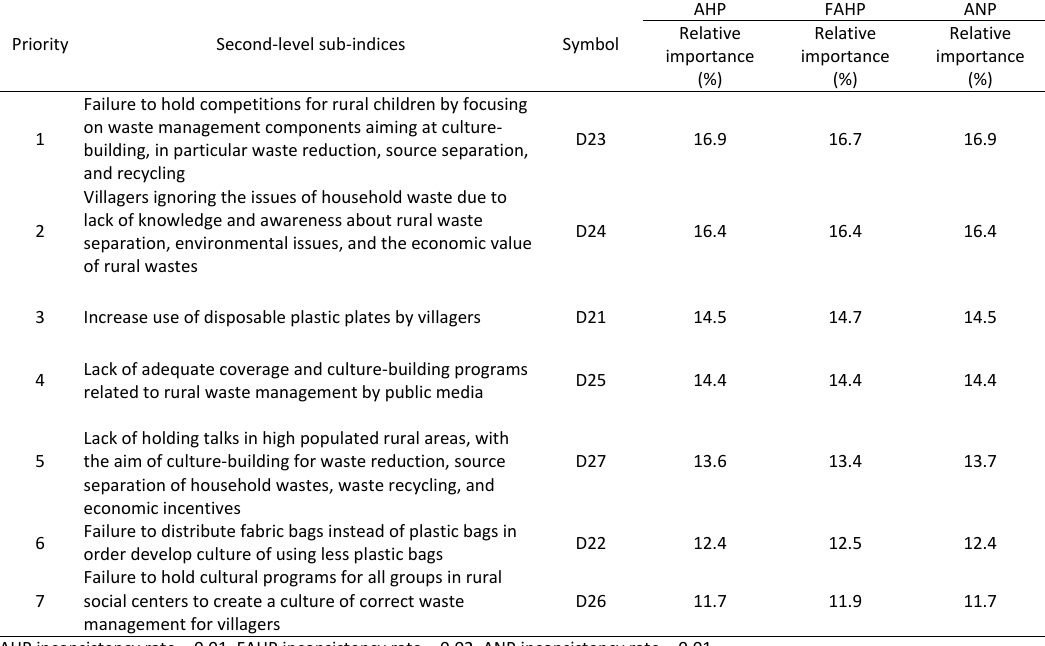
Table 7: Prioritization of weaknesses and relative importance values of the sub-indices of the D2 index based on AHP, FAHP, and ANP